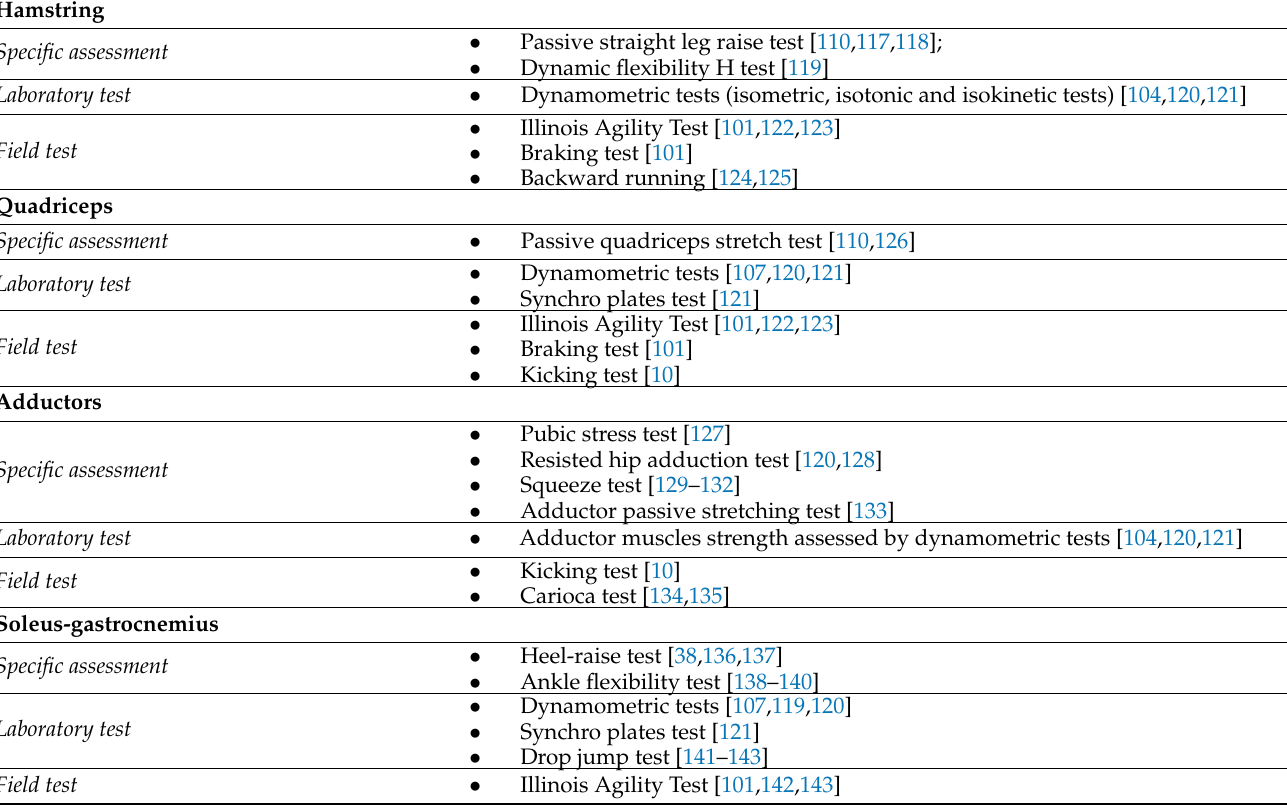
Table 6. Return to play (RTP) specific tests for muscle